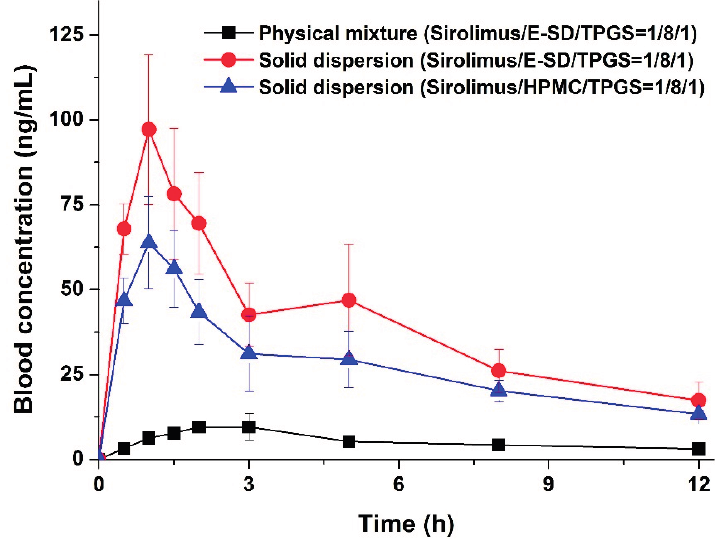
Figure 7. Blood concentration-time profile of sirolimus in rats after oral administration of sirolimus-loaded solid dispersions and the physical mixture. Data are expressed as the mean ± standard deviation ( n =